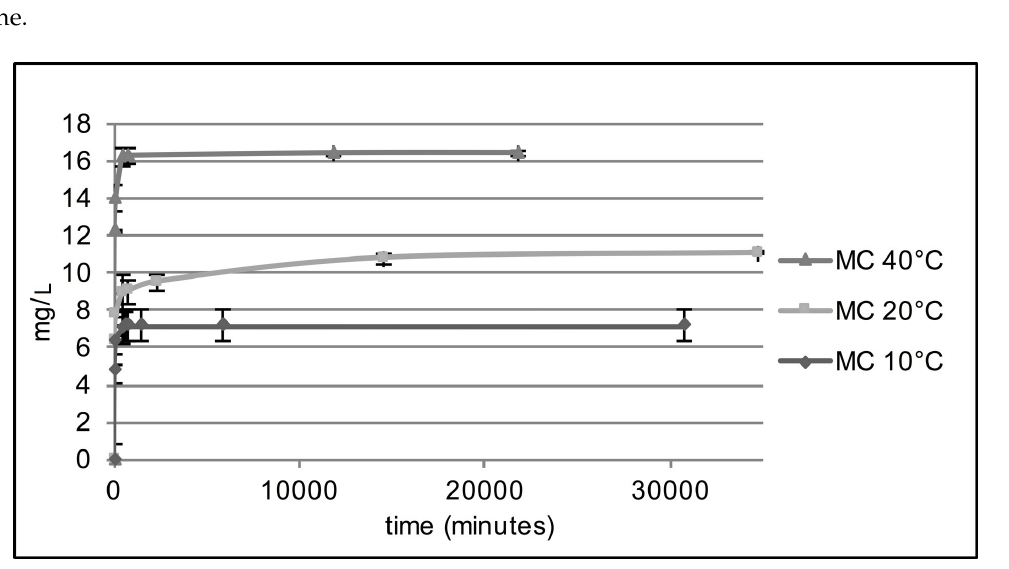
Figure 1. Release profiles of natamycin from methylcellulose films (MC) at different temperatures. Each dot represents the mean of the experimental data with an error bar of 2 replications.